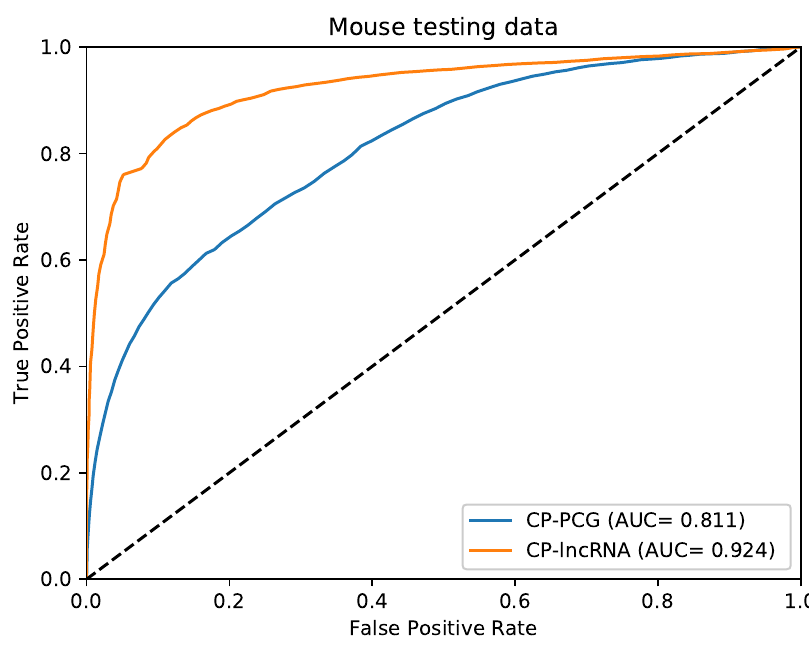
Figure 4. ROC curves for the testing mouse data on the CP-PCG and the CP-lncRNA, which are trained on human data using “only the sequence features”,